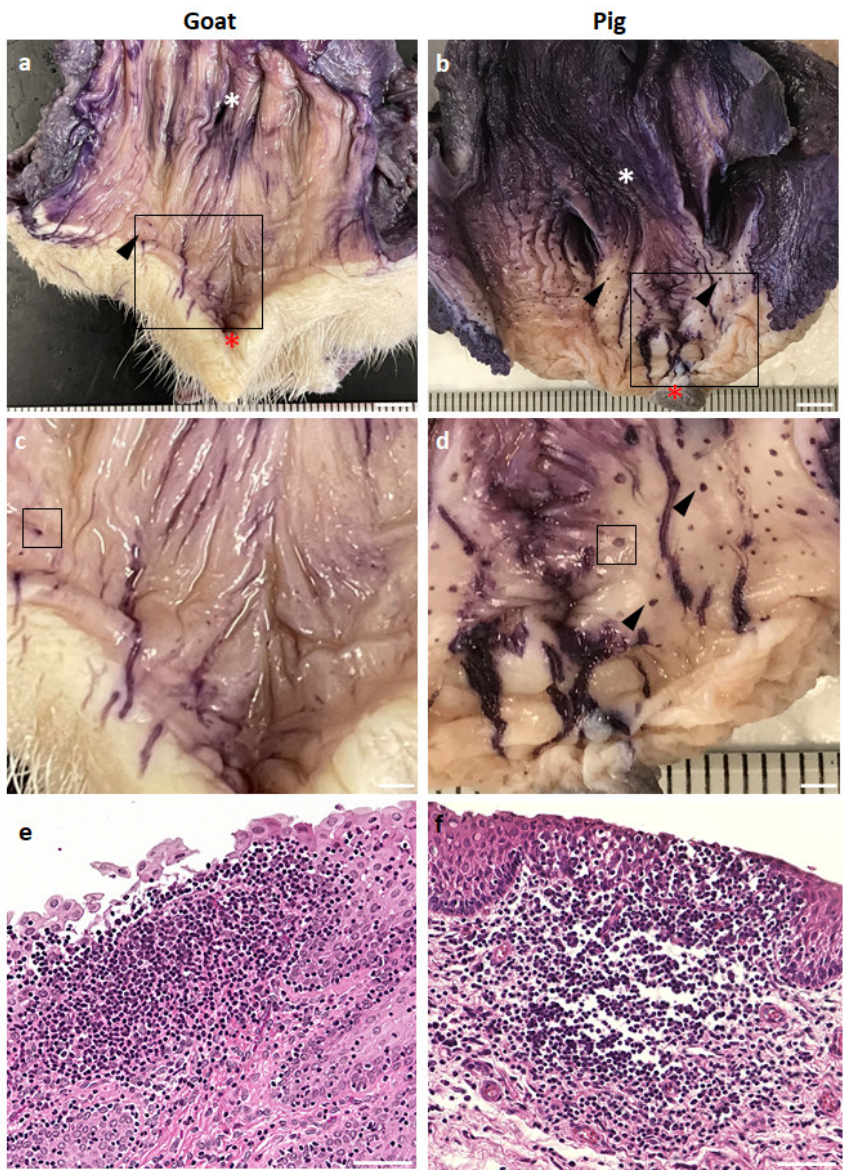
Figure 1. Scattered GOALTs distributed throughout the mucosa of the VV and EPGOs of goat and pig ( a , b ). Goat ( a ) and pig ( b ) VV and EPGOs after the whole-mount staining with hematoxylin, showing navy-blue spots. White asterisks show the external urethral orifice. Red asterisks show the clitoris. Black arrowheads indicate navy-blue spots. Scale bars = 5 mm. ( c , d ) Enlarged images of the VV mucosa squared areas in panels ( a , b ). bars = 2 mm. ( e , f ) Histology of navy-blue spot squared areas in panel ( c , d ). H&E staining. Scale bar = 50 µ